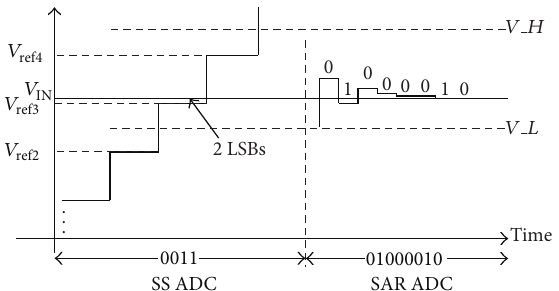
Figure 3: The operating principal of the proposed ADC without quantization noise.